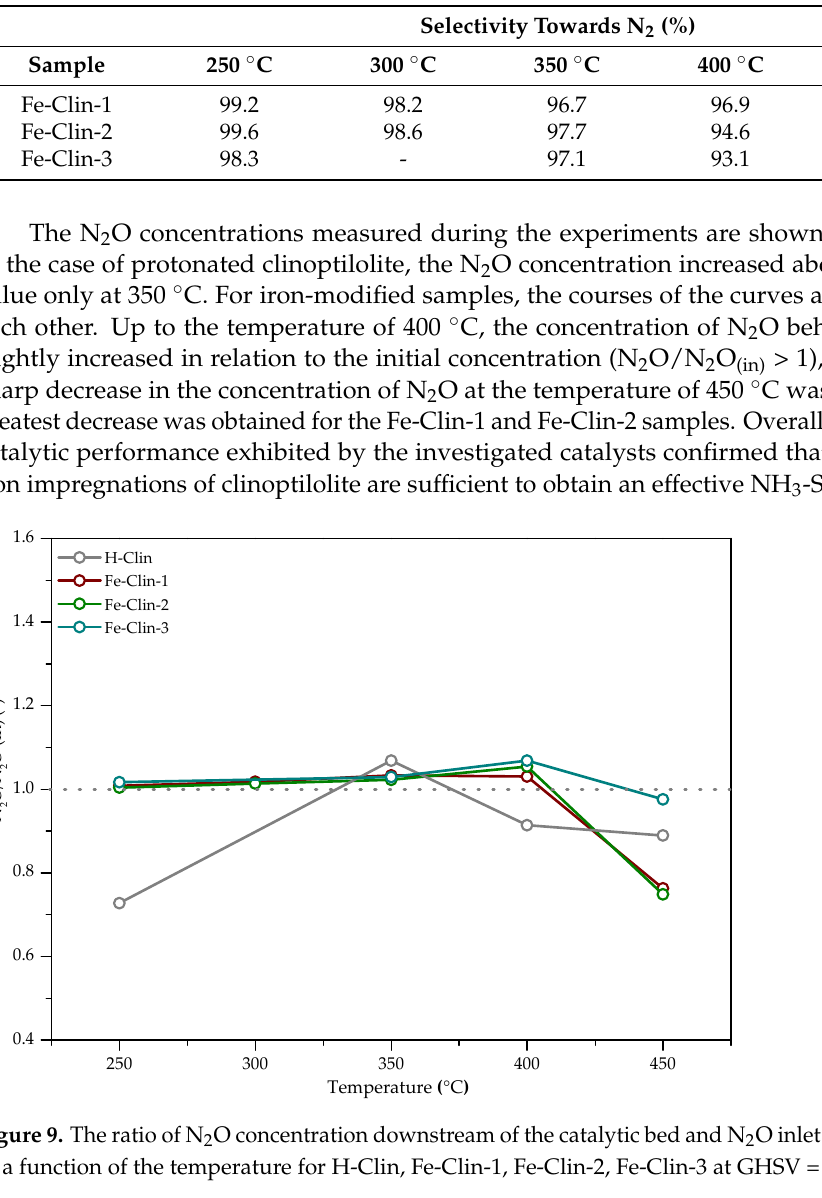
Figure 10. Schematic preparation procedure of Fe-clinoptilolite catalysts. The formed samples of protonated clinoptilolite and Fe-clinoptilolite catalysts, pre- pared on a laboratory scale, are presented in Figure 11A,B, respectively. The codes of the samples with the corresponding descriptions are listed in Table 4.